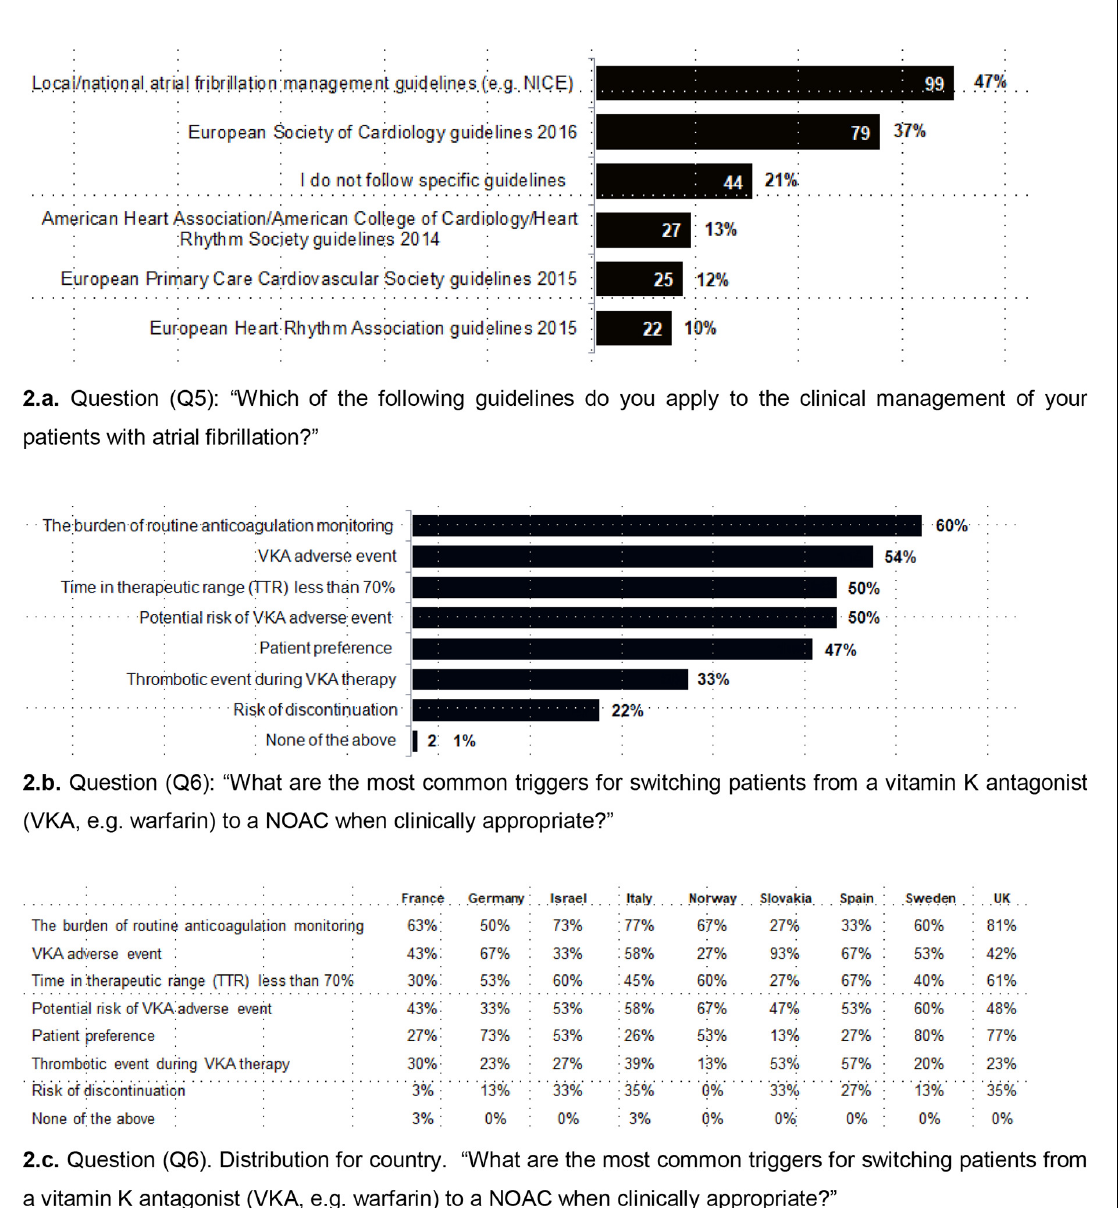
Figure 2. Familiarity with atrial fibrillation stroke guidelines on NOACs use and anticoagulant switching NOAC = non-VKA oral anticoagulant. VKA = vitamin K